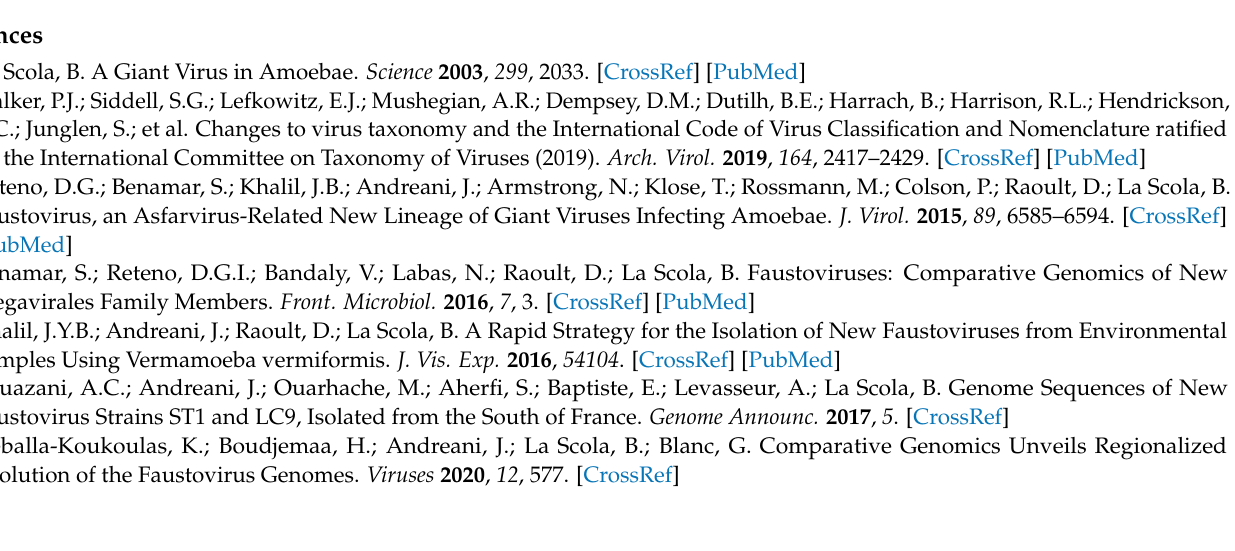
Figure S2: Phylogenetic reconstruction of homing endonucleases, Figure S3: gene distribution in the K-LCC10 genome. Table S1: average pairwise protein distances between 40 single-copy core gene families of extended